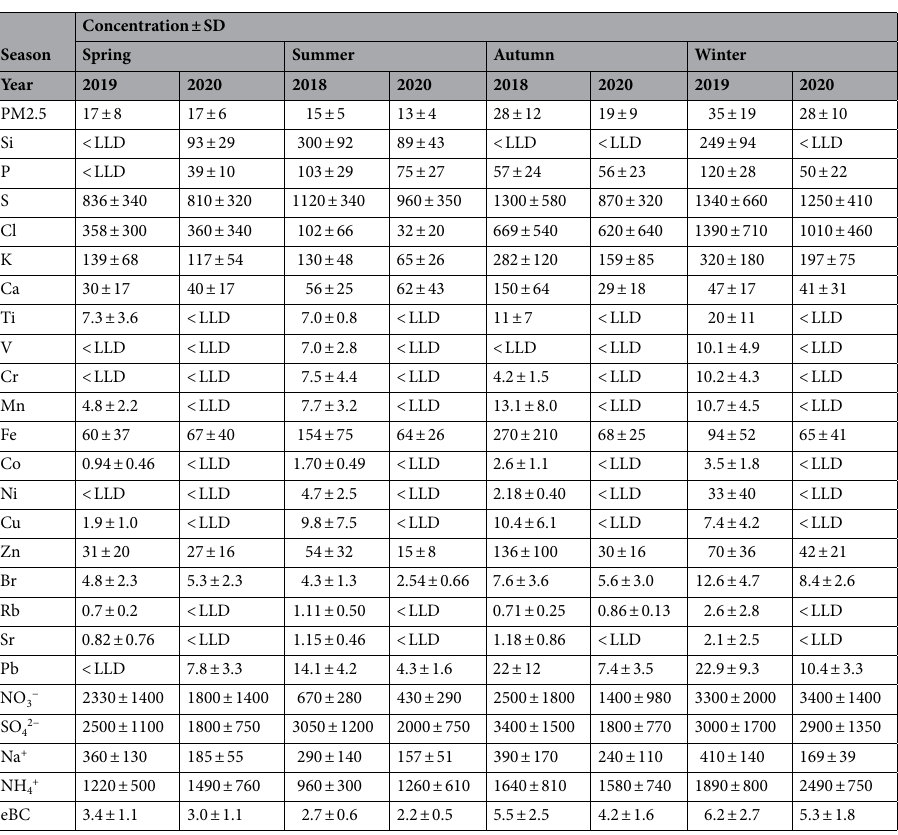
Table 1. The seasonal PM 2.5 (in μg/m 3 ), chemical elements (in ng/m 3 ), ions (in ng/m 3 ) and eblack carbon (in μg/m 3 ) concentrations with variability of measurements for the year 2018/2019 and 2020/2021. SD variability of the concentration during measuring